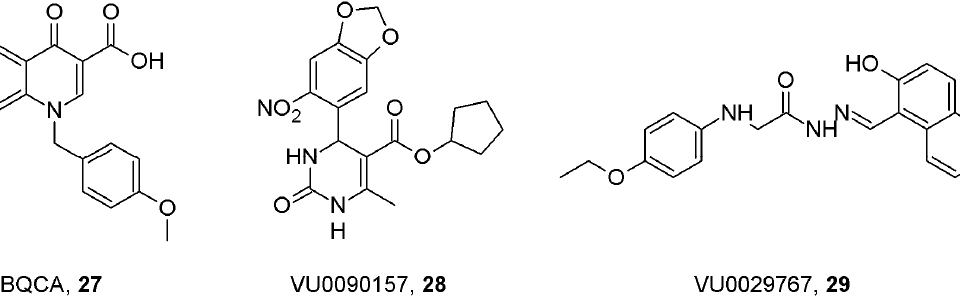
Figure 8. Structure of M